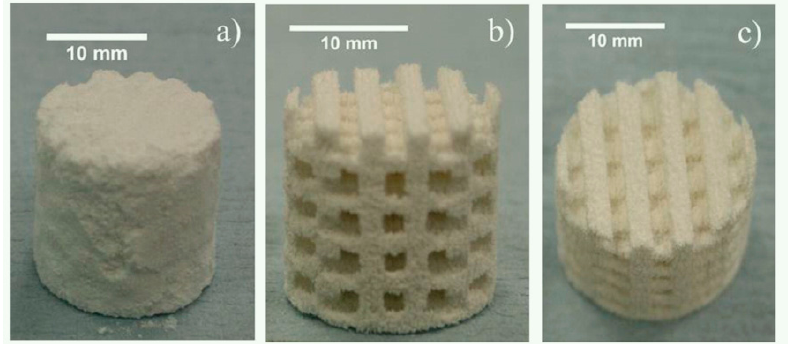
Figure 6. ( a ) 3D Inkjet ‐ printed scaffold as removed from the build bed; ( b – c ) depowdered scaffold.